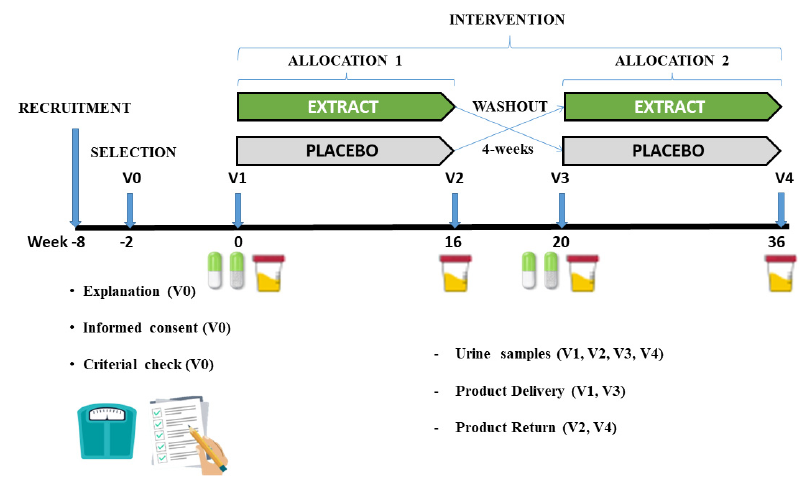
Figure 1. Graphical representation of the different phases of the study.